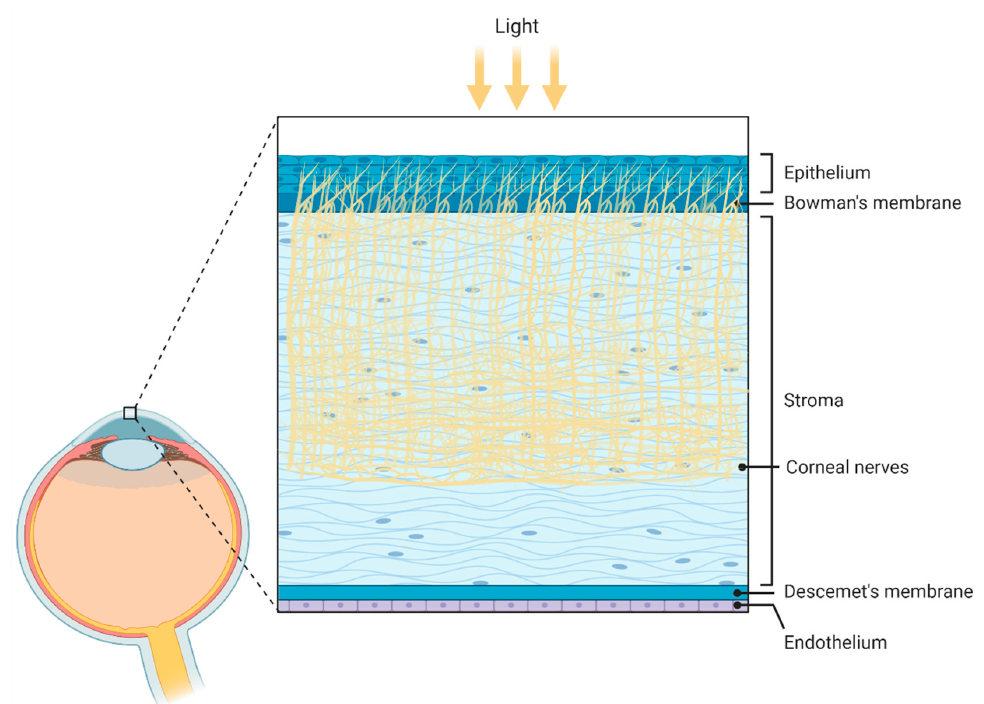
Figure 4. Schematic illustration of the corneal anatomy showing its different layers and structures. From outer to inner: epithelium, Bowmans’s membrane (containing collagen fibers), stroma (containing corneal innervation), Descemet’s membrane, and endothelium. Figure created by BioRender.com software (Toronto, ON, Canada).